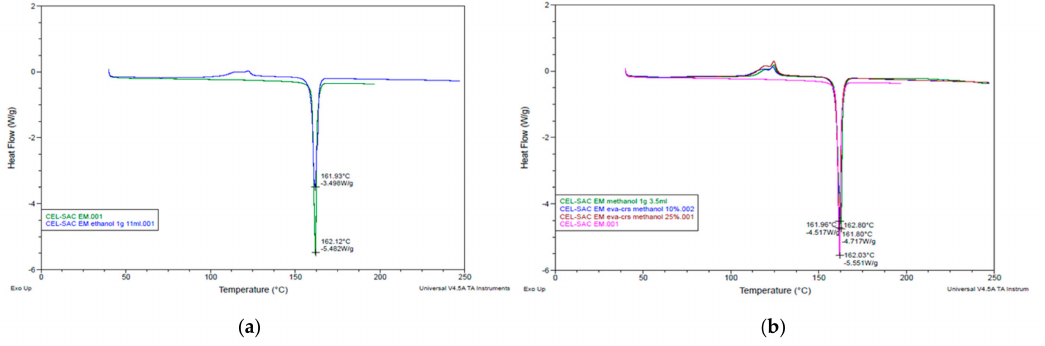
Figure 4. DSC results of CEL-SAC EM: ( a ) ethanol-assisted EM; ( b ) methanol-assisted